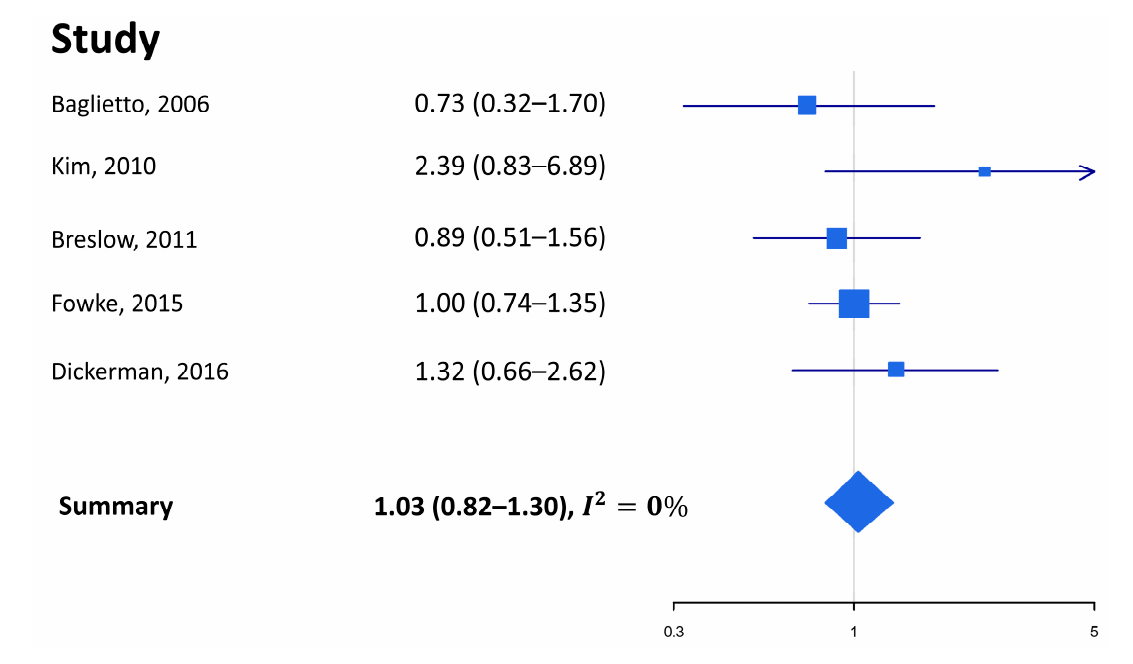
Figure 3. Forest plot of the measures of association between alcohol intake (highest vs. lowest category) and prostate cancer mortality [12,33–36]. Table 3. Summary results of the studies included in the review that reported on the association between alcohol intake and the overall and cancer-specific survival of prostate cancer